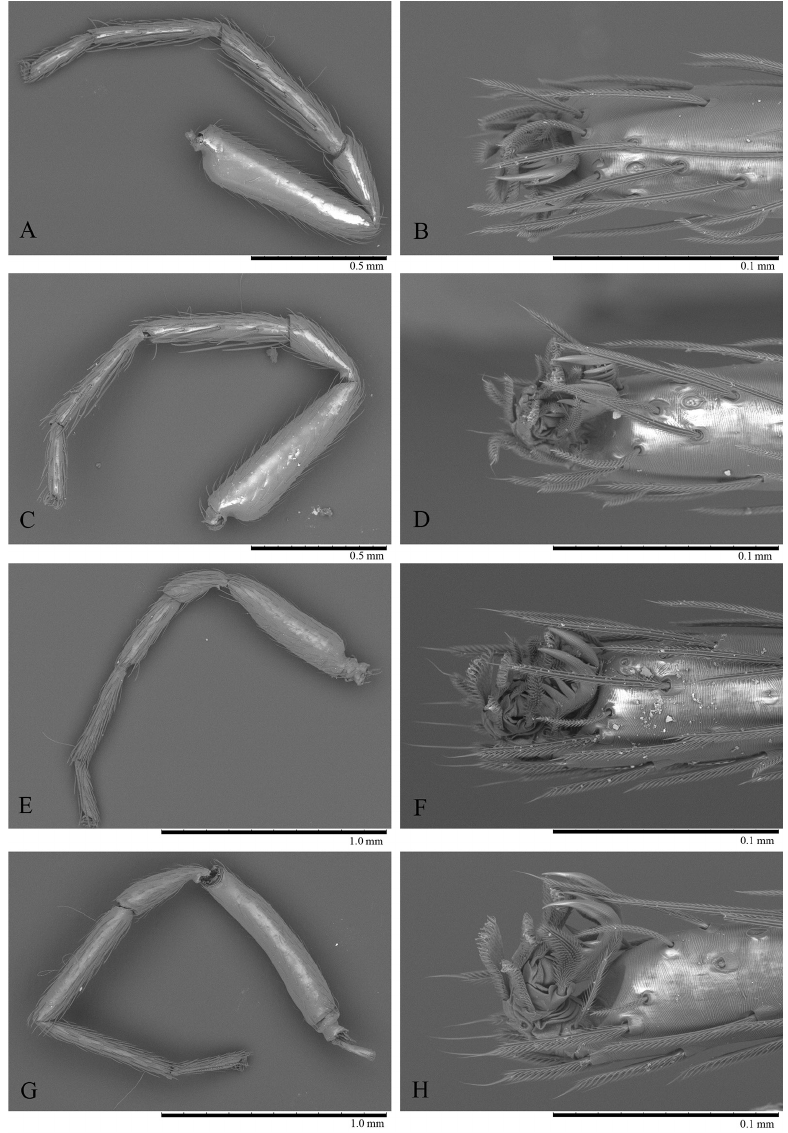
Figure 4. Trilacuna simianshan sp. n., female, right legs, SEM. A leg I, prolateral view B tarsus I, dorsal view C leg II, prolateral view D tarsus II, dorsal view E leg III, prolateral view F tarsus III, dorsal view G leg IV, prolateral view H tarsus IV, prolateral view. small “papillae”. The base of the embolus system with a wing-like, membranous pro- jection (mp) in prolateral view and a circular projection (cp) covered with scales in retrolateral view; middle part of the embolus system with a rectangular projection (rp) in dorsal